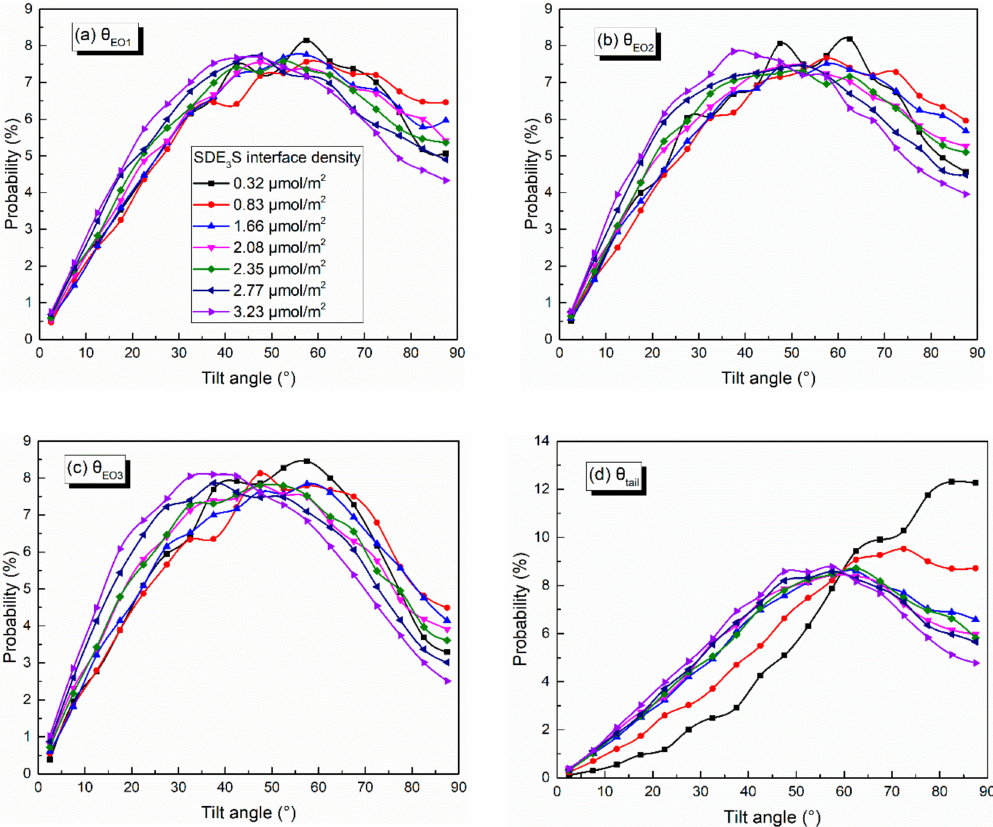
Figure 11. Tilt angles of ( a ) θ EO1 , (b ) θ EO2 , ( c ) θ EO3 , and ( d ) θ tail in SDE 3 S